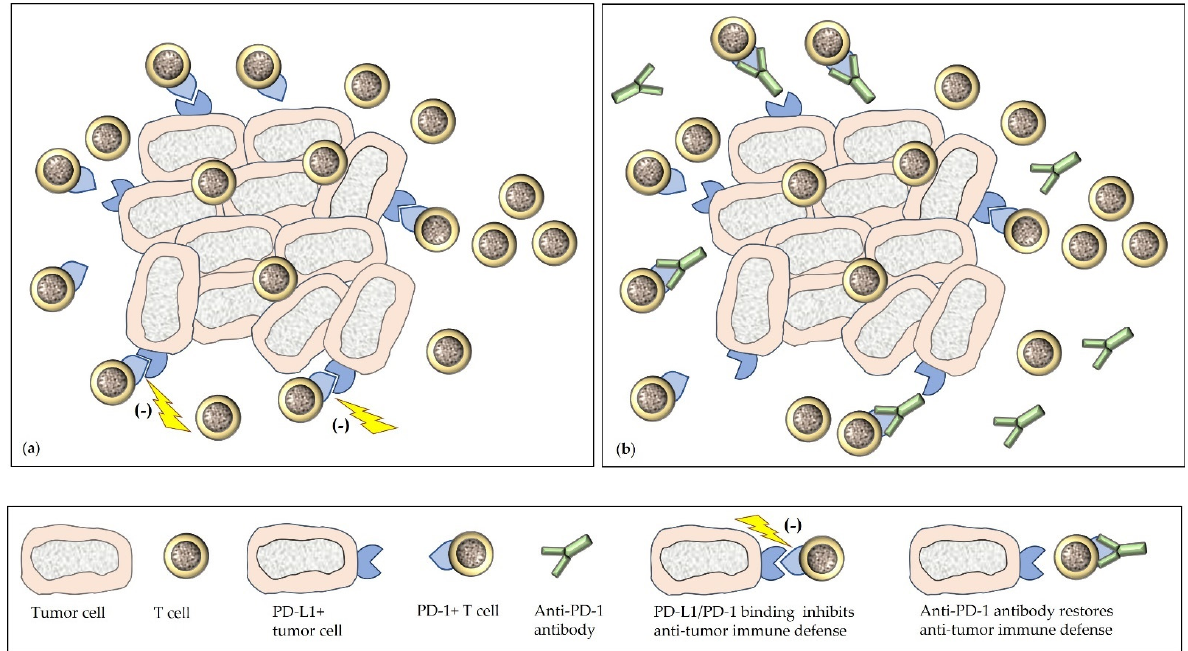
Figure 7. Chronic immune stimulation leads to the exhaustion of lymphocytes that upregulate the immune checkpoint molecule PD-1. Its binding to PD-L1, expressed on tumor cells (depicted), lymphocytes and macrophages, downregulates the anti-cancer immune response ( a ). Blocking of PD-1 (as illustrated) or PD-L1 by monoclonal antibodies restores the anti-cancer immune response ( b ). This is the mechanism of the immune checkpoint therapy.